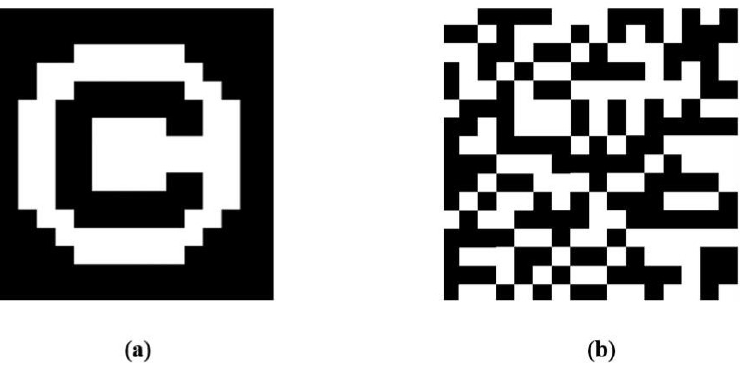
Figure 7. Watermark images. ( a ) Original watermark image; ( b ) scrambled watermark image.